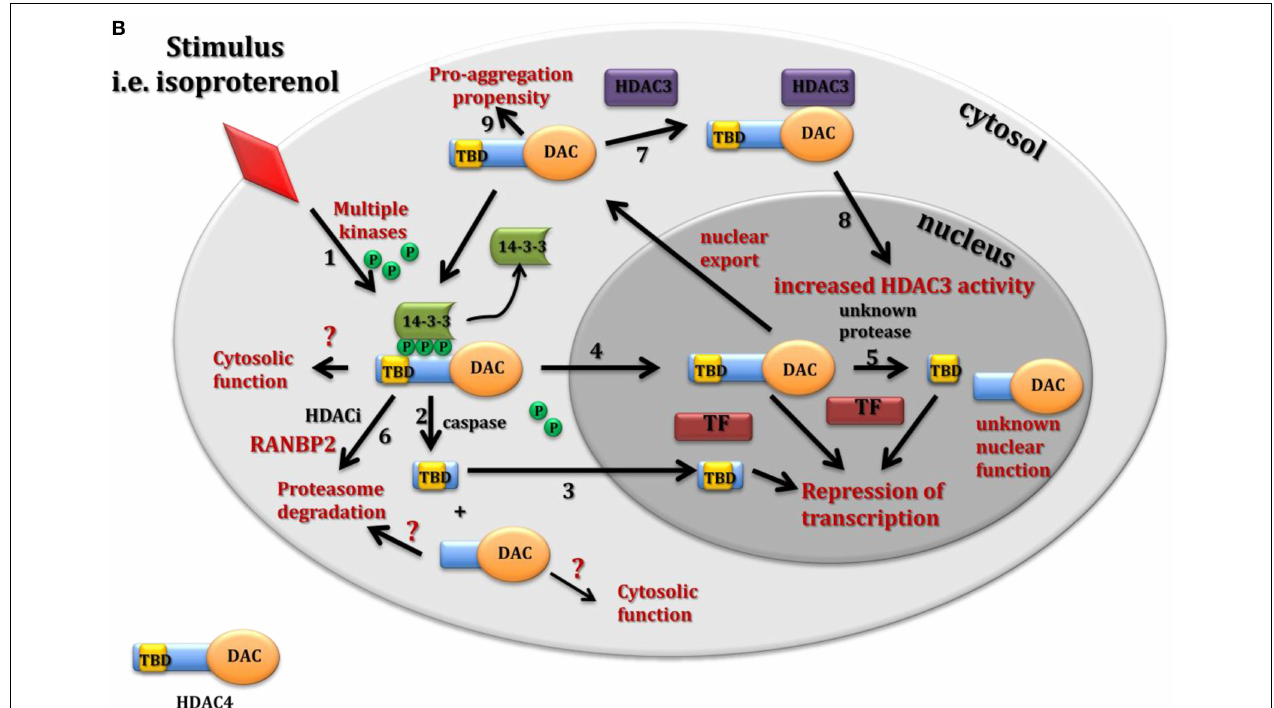
FIGURE 1 | Structure and cellular function of HDAC4. (A) Summary of HDAC4 post translational modifications. CC, coil-coil domain; TBD, transcription binding domain; NLS, nuclear localisation signal; NES, nuclear export signal; DAC, deacetylation domain. (B) Summary underlying HDAC4 cellular localization and identified functions spanning all tested systems. HDAC4 undergoes nuclear-cytoplasmic shuttling in response to different stimuli through multiple kinases (1). In the cytoplasm, HDAC4 might be cleaved by proteases (2) to generate a small N-terminal fragment that translocates into the nuclei (3) to bind different transcription factors (TF) and